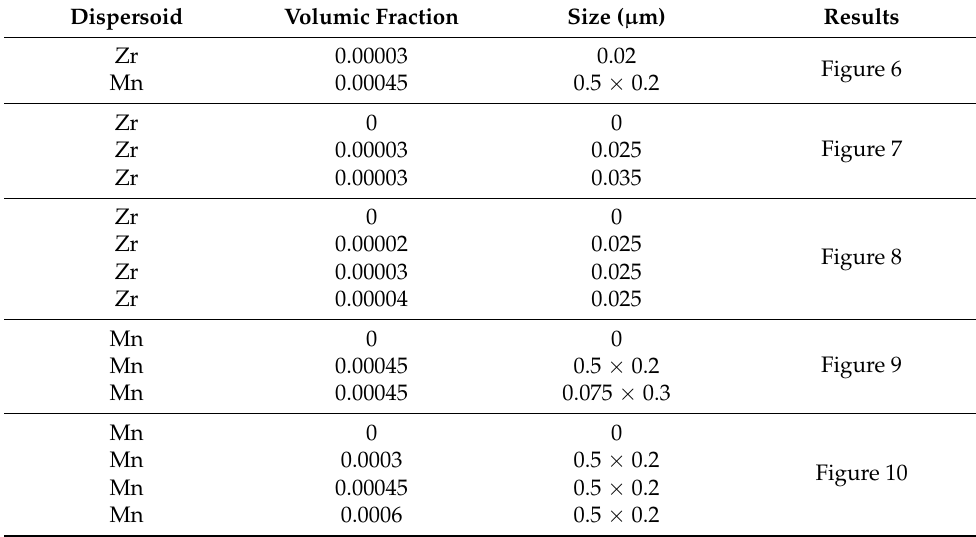
Table 3. Range of the particle radii and volume fractions investigated in the DDD simulation campaign. The last column gives the figure where the results will be